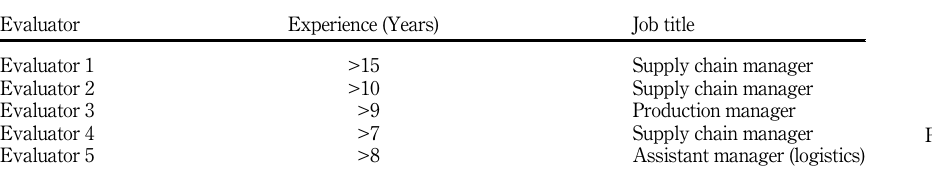
Table 5. Profile of the